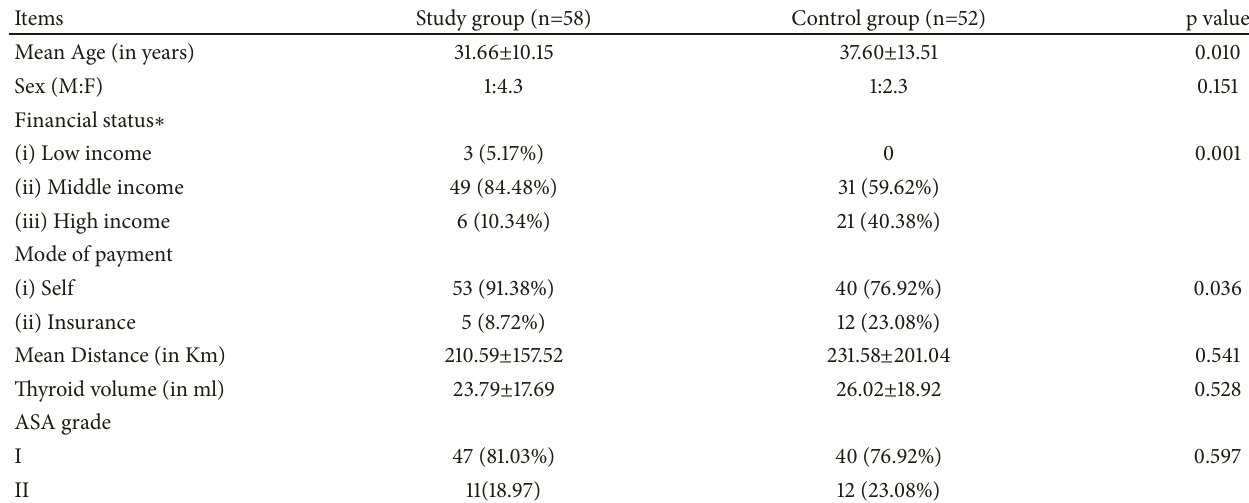
Table 2: Patients clinical and socioeconomic profile.